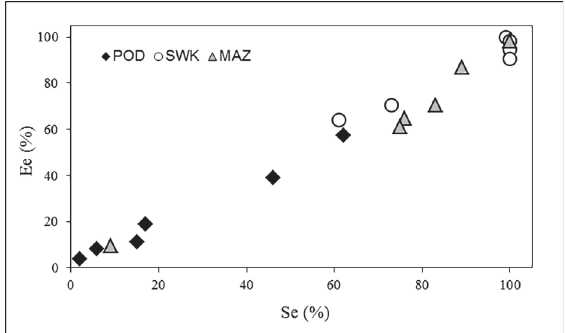
Fig 3. The relationship between endophyte infection rate of seeds (Se) and plants (Ee). Regions: POD – Podlaskie. SWK – Ś wi ę tokrzyskie. MAZ – Mazowieckie.